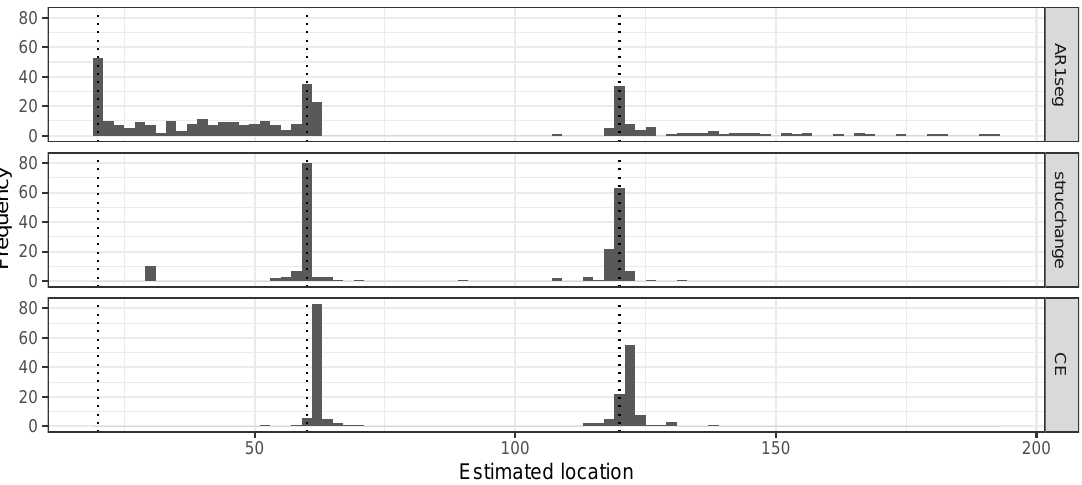
Figure 6. Frequency of the estimated locations when N > 0; the true profile of change-points is at 20, 60,